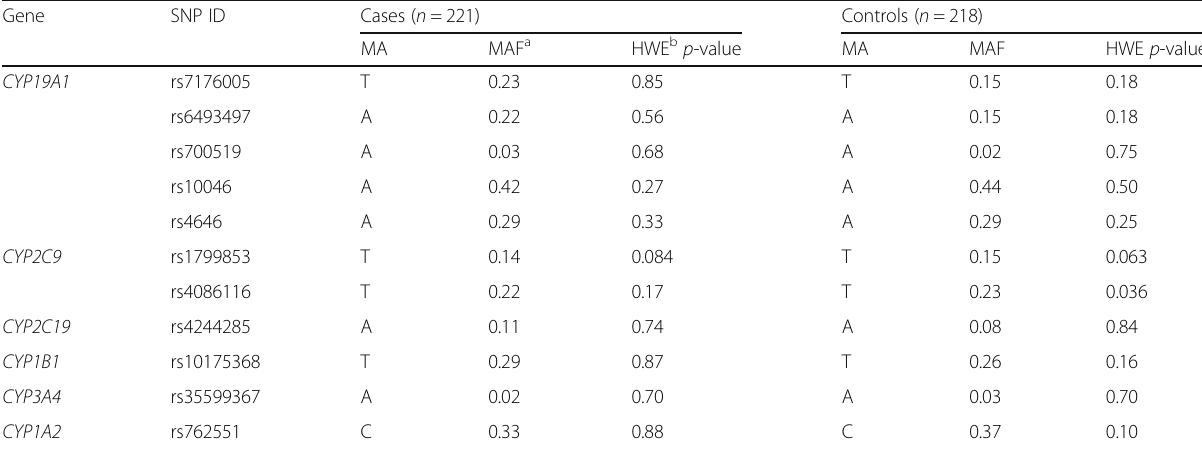
Table 2 Minor allele frequencies among breast cancer patients and healthy controls and the HWEc P -value of CYP450 candidate gene polymorphisms